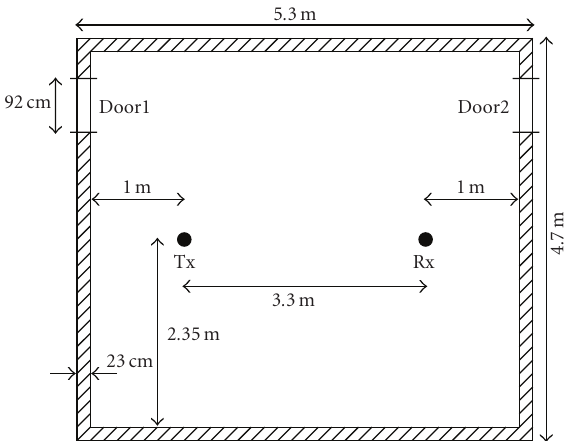
Figure 8: Experiment room with position of the transceiver (Tx) and the receiver (Rx) for temporal response